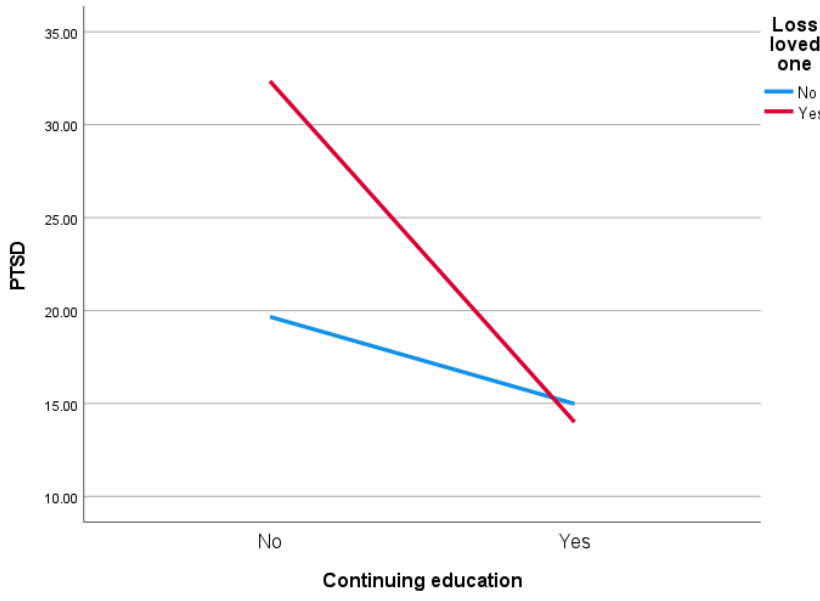
Figure 1. Effect of loss of loved one and continuing education on PTSD score.